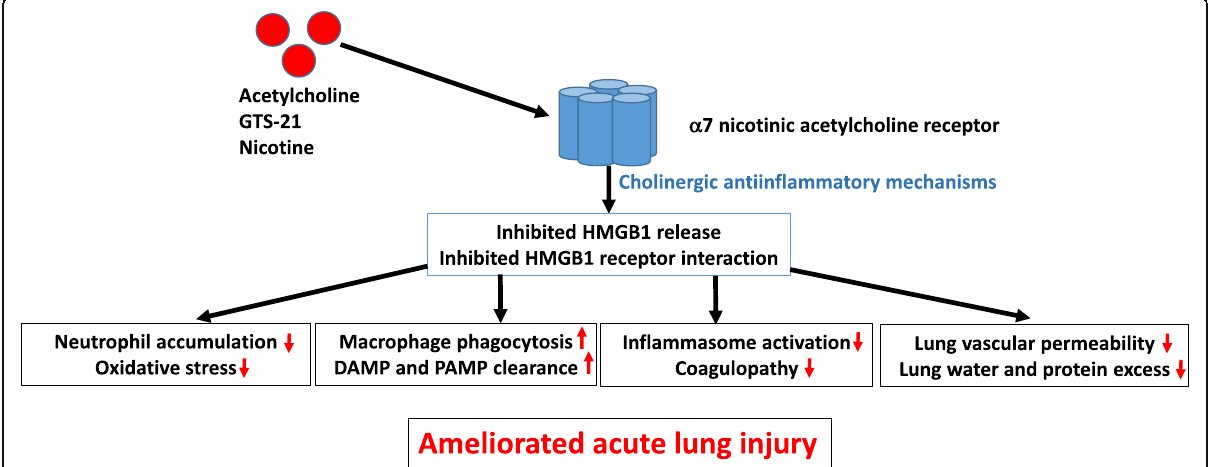
Fig. 1 The cholinergic antiinflammatory pathway alleviates acute lung injury. Agonists to α 7 nicotinic acetylcholine receptors reduce release of extracellular HMGB1 and expression of the two main HMGB1 receptors RAGE and TLR4. The inhibition of HMGB1-driven inflammation ameliorates the development of acute lung injury and ARDS by constraining certain and supporting other cellular functions outlined in the